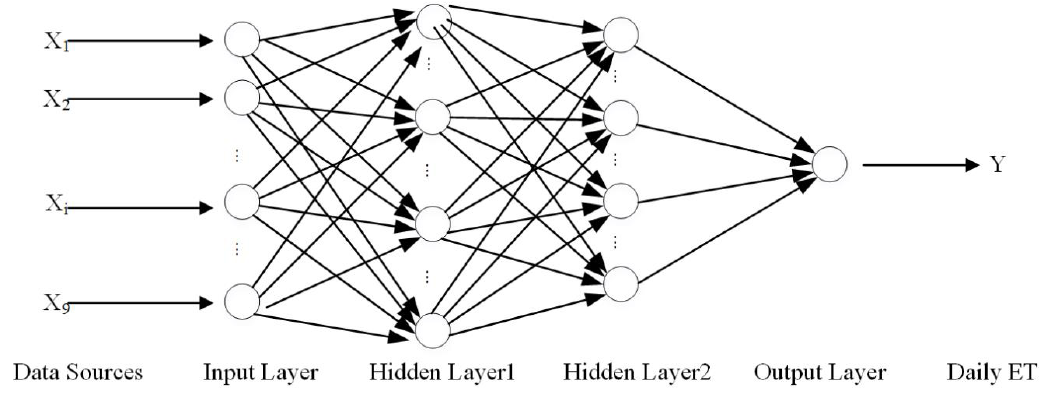
Figure 3. Structure of the DNN used in the study.